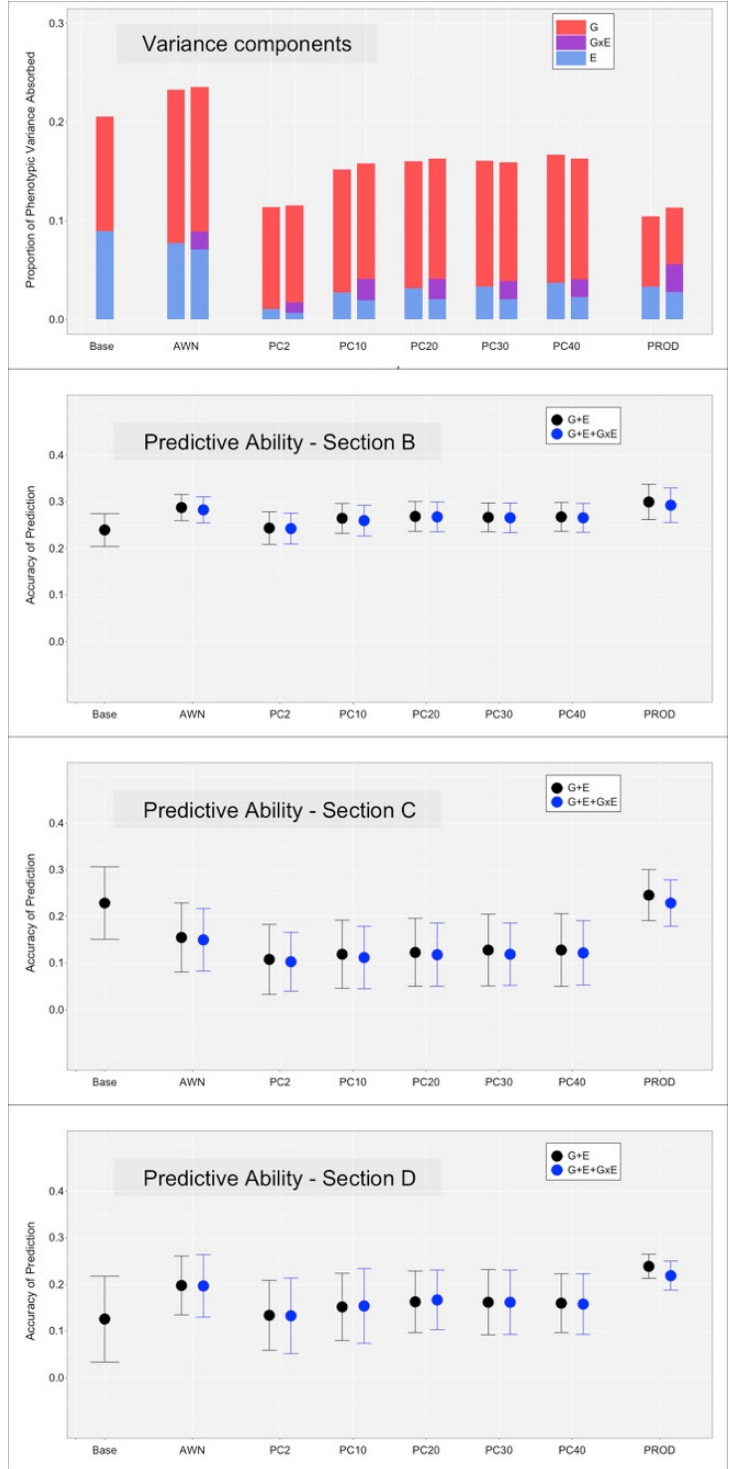
Figure 4. Proportion of variance components explained by the additive genetic effect (G), environ- mental effect (E), and their interaction (GxE) term, together with predictive ability of the respective models under the different scenarios for somatic cell score (SCS). The black dots (and bars) refer to the models that included the G and E terms, the blue dots (and bars) refer to the models that included the G, E, and GxE terms.